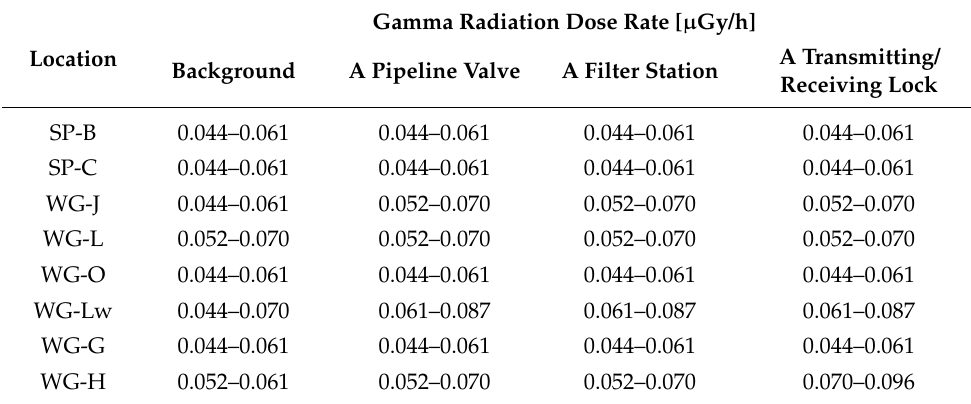
Table 3. Gamma radiation dose rate around selected gas pipeline